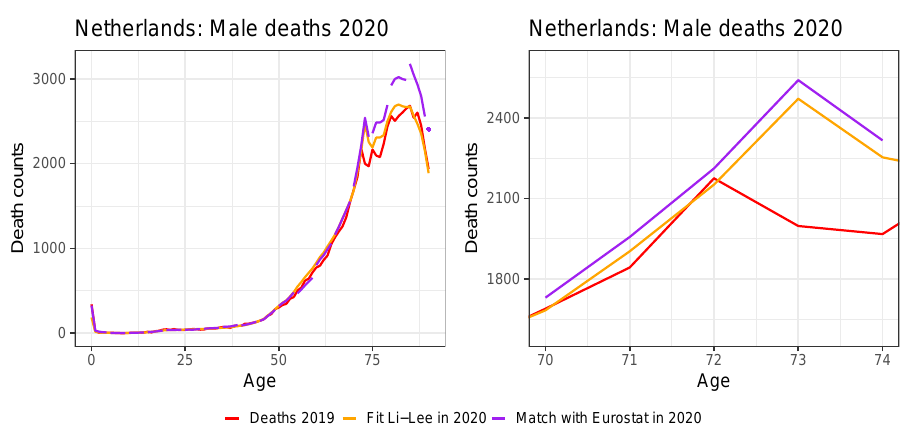
Figure A4. Construction of the virtual deaths in individual ages in the Netherlands for